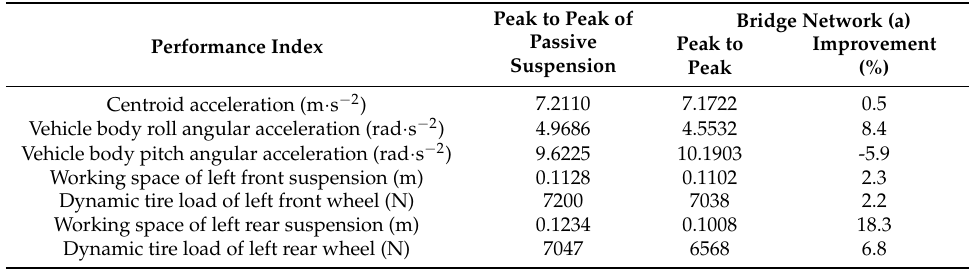
Table 7. Performance index with a pulse road